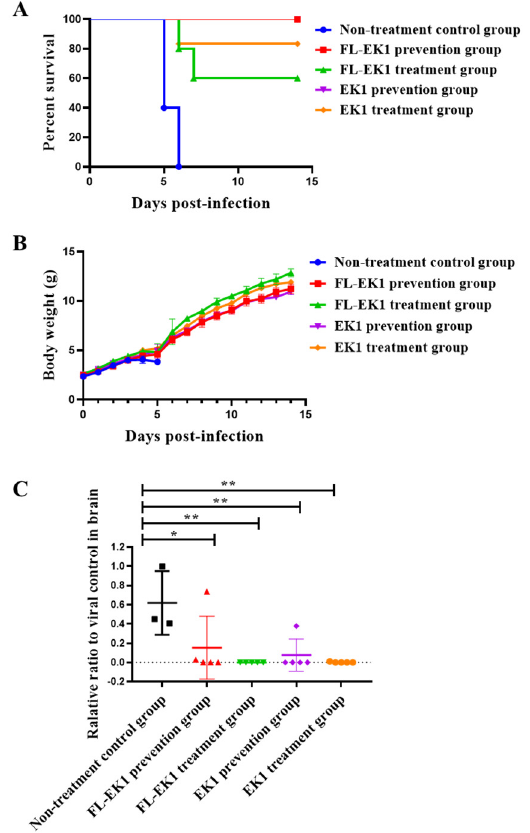
Figure 4. FL-EK1-mediated inhibition of authentic HCoV-OC43 infection in vivo. In vivo prophylactic and protective efficacy of FL-EK1 and EK1 against authentic HCoV-OC43 infection in ICR suckling mice via the intranasal route for FL-EK1 administration and viral challenge. Mouse survival rate ( A ) and bodyweight changes ( B ) were recorded. Viral titer in the brain was measured by real-time PCR ( C ). Samples were tested in triplicate, and the RT-PCR was repeated twice. Data from a representative experiment are presented as mean ± SD. * p < 0.05, ** p < 0.01.